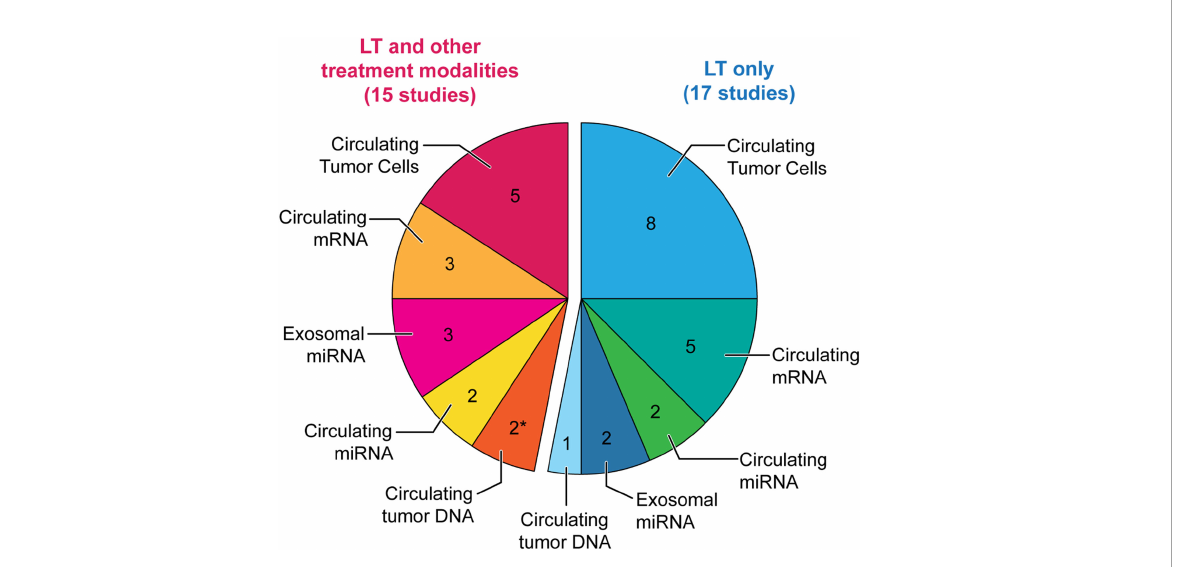
FIGURE 1 Pie chart of the available studies on liquid biopsy in LT for HCC. Pie chart illustrating the number of available studies on liquid biopsy in liver transplant (LT) for hepatocellular carcinoma (HCC), for each circulating analyte. Blue: Studies only including LT. Pink: Studies including LT and other treatment modalities. * including one study providing preliminary data